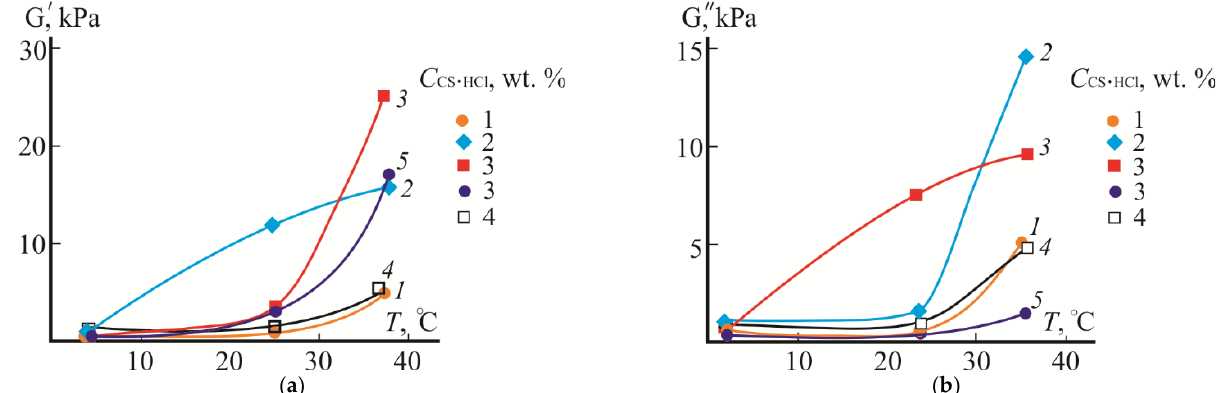
Figure 1. Temperature dependences of the moduli of elasticity ( a ) and loss ( b ) of the aqueous CS·HCl : Pl F-127 = 30:70 (vol./vol.) mixture with С CS·HCl = 1–4 wt.%, С Pl F-127 = 25 wt.% without ( 1 – 4 ) and with the addition of 3 wt.% D-AscA ( 5 ).